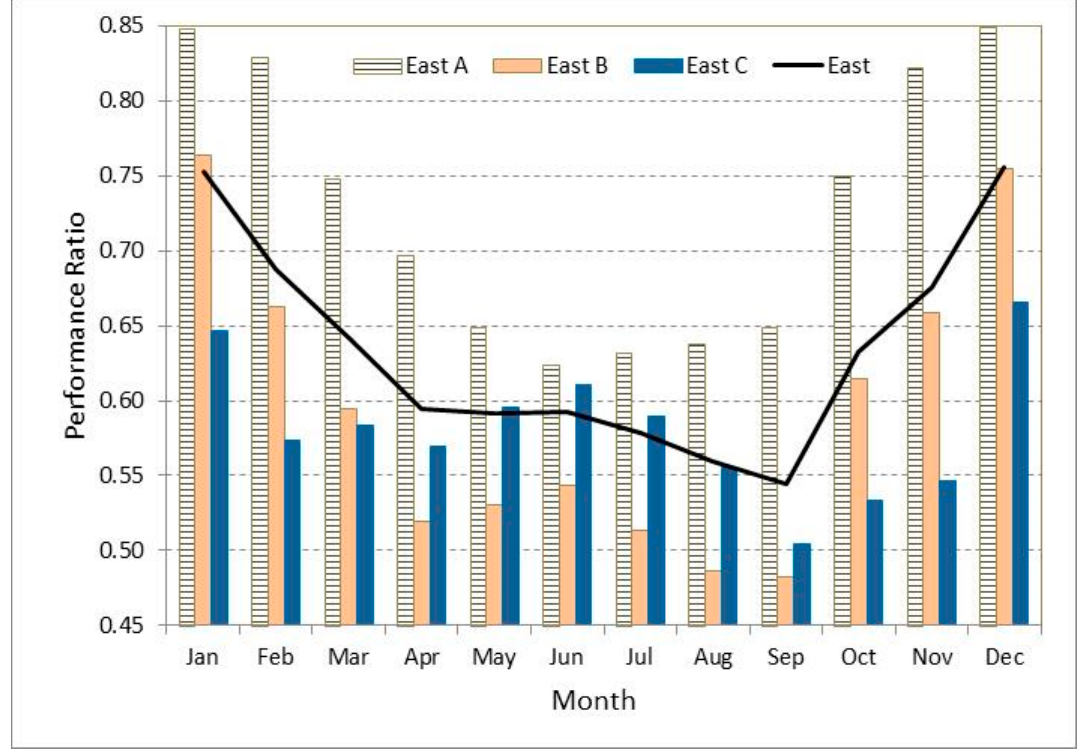
Figure 11. Performance ratio of each of the three equivalent subsystems of the east façade, and average PR value of the whole east façade (line).